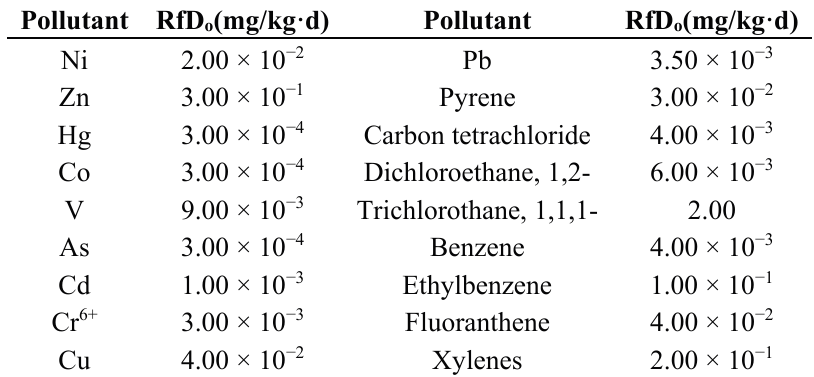
Table A2. Reference oral intake dose (RfD o ) of non-carcinogenic pollutants (From the Technical Guidelines for Risk Assessment of Contaminated Sites HJ 25.3-2014